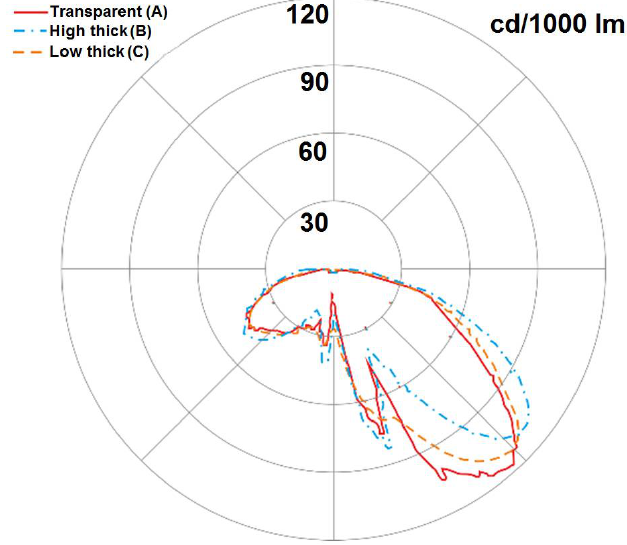
Figure 5. Comparative Photometric diagram of the C90–C270 planes for the test lamp with the 3 covers tested.